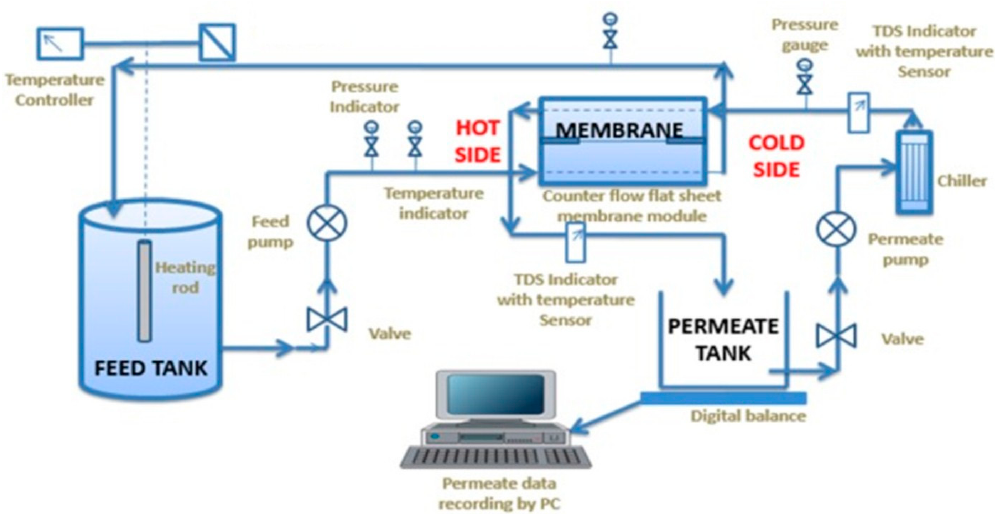
Figure 12. A typical DCMD apparatus. Reprinted from [83]. Copyright (2017) with permission from Elsevier.